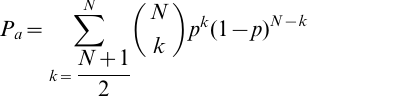
Figure S1 The vertical axis is the constant added to ‘‘c’’